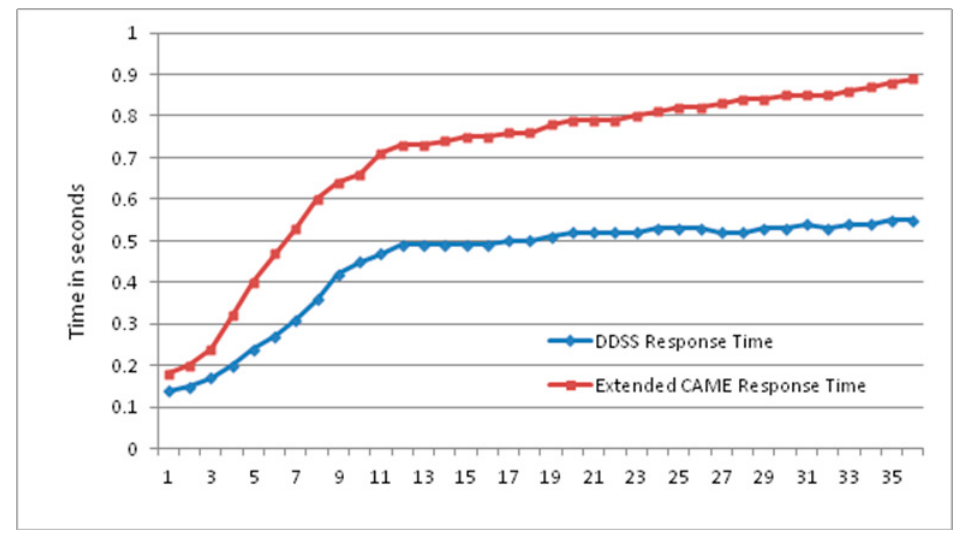
Figure 11. Response time comparison of proposed system recommendation generation against Extended CAME [19].